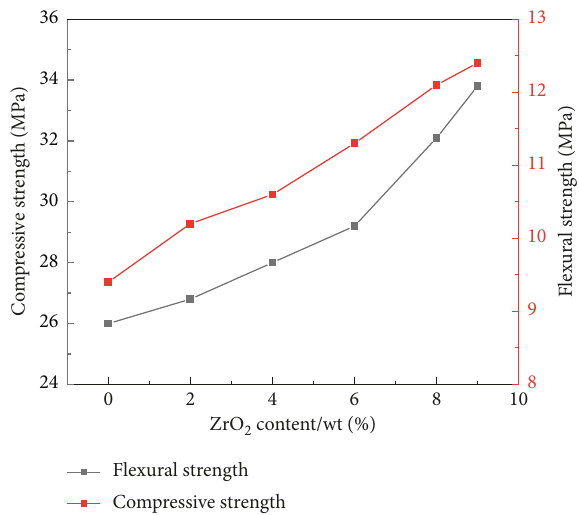
Figure 3: Effect of ZrO 2 amount on flexural strength and com- pressive strength of mullite porous ceramics.